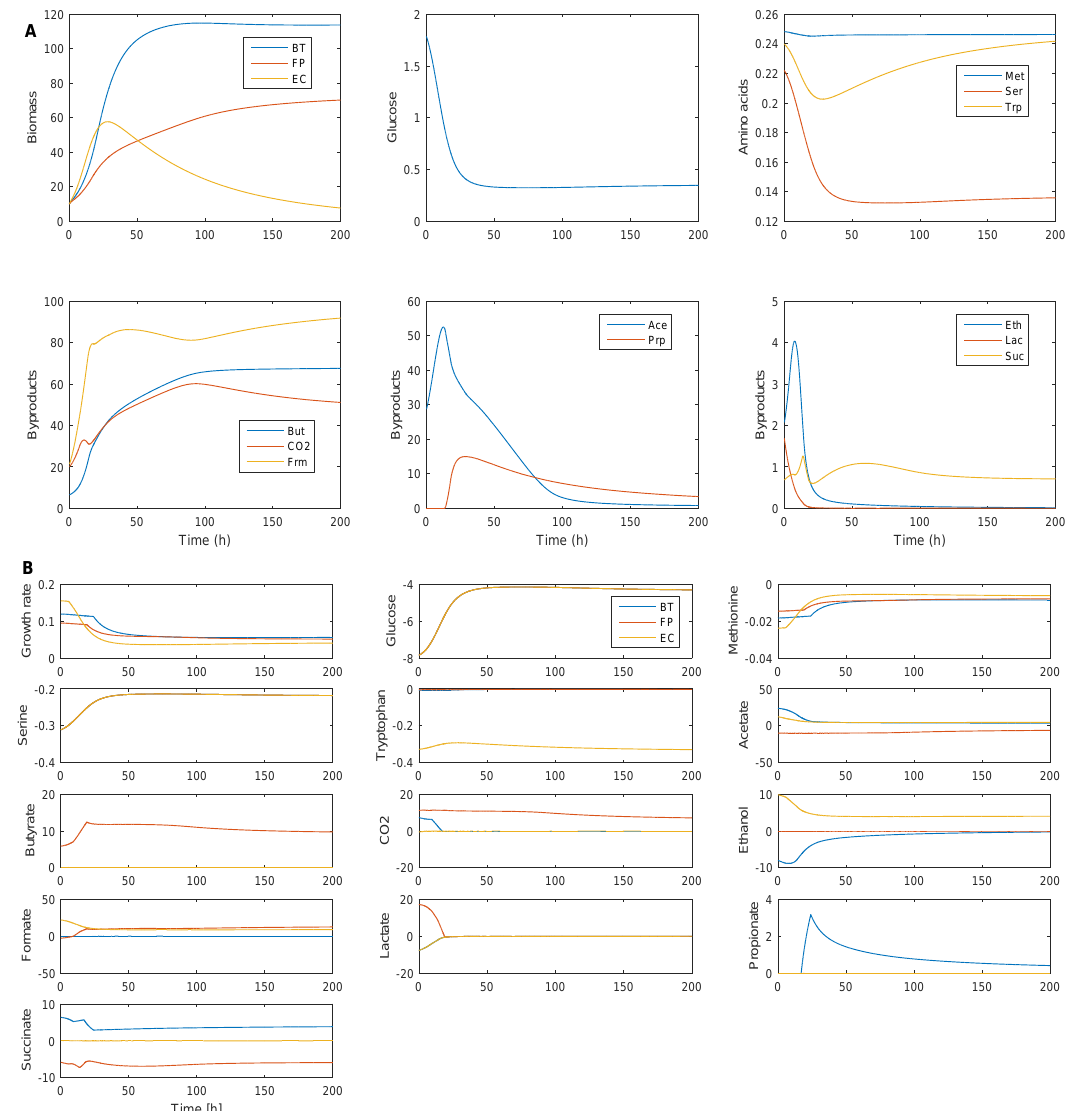
Figure 3. Time profiles predicted in the middle of the multispecies biofilm with byproduct cross feeding. ( A ) Biomass, nutrient and byproduct concentrations. Units are g/L for biomass and mmol/L for the nutrients and byproducts; ( B ) Species growth, uptake and secretion rates. Units are h − 1 for the growth rate and mmol/gDW/h for the other rates. Uptake rates are negative and secretion rates are positive. Amino acids: Met denotes methionine, Ser denotes serine and Trp denotes tryptophan. Byproducts: Ace denotes acetate, But denotes butyrate, Eth denotes ethanol, Frm denotes formate, Lac denotes lactate, Prp denotes propionate and Suc denotes